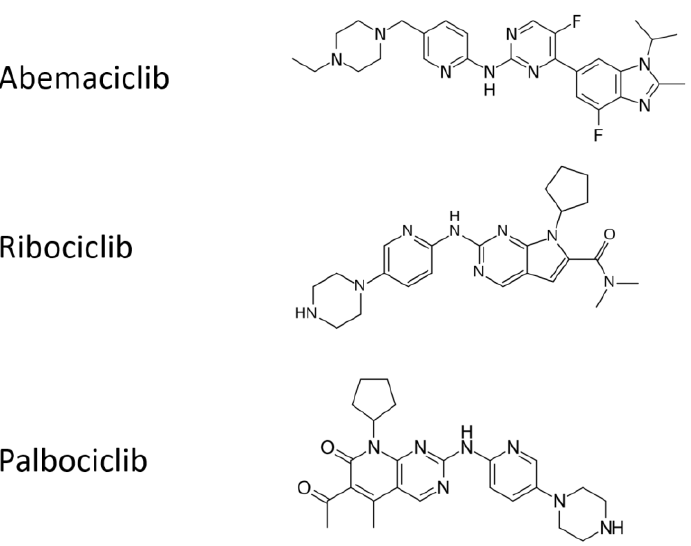
Figure 2. Chemical structures of cyclin inhibitors that are currently approved.